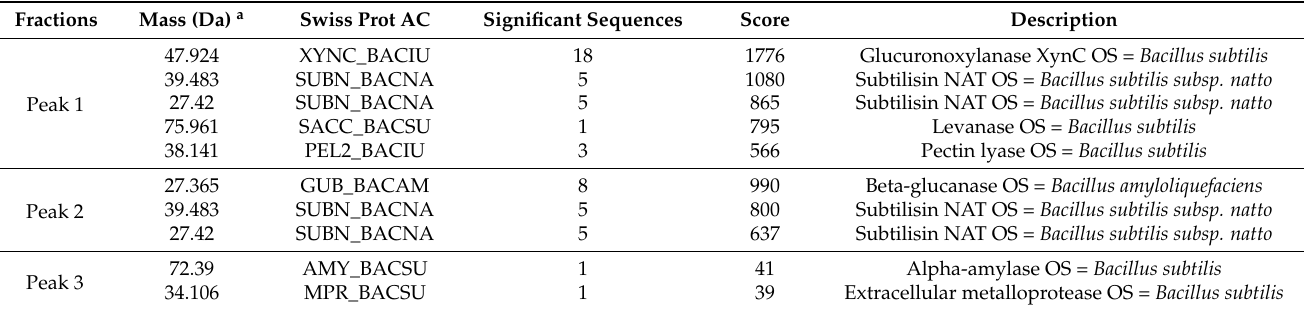
Table 2. The proteins identified on the three peaks are listed with their accession (AC) numbers and molecular weights. Fractions Mass (Da) a Swiss Prot